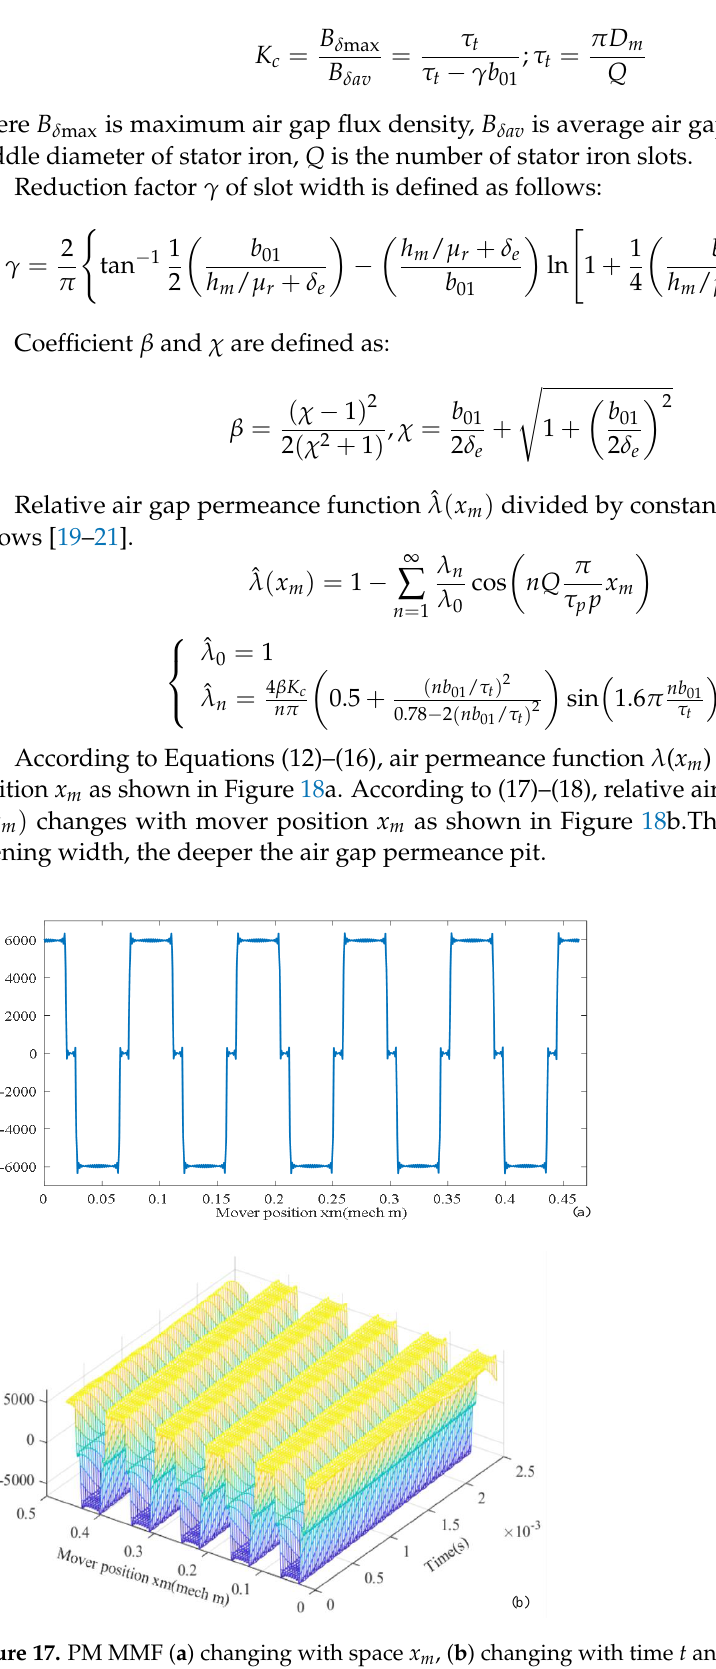
m , ( b ) changing with time t and space x m